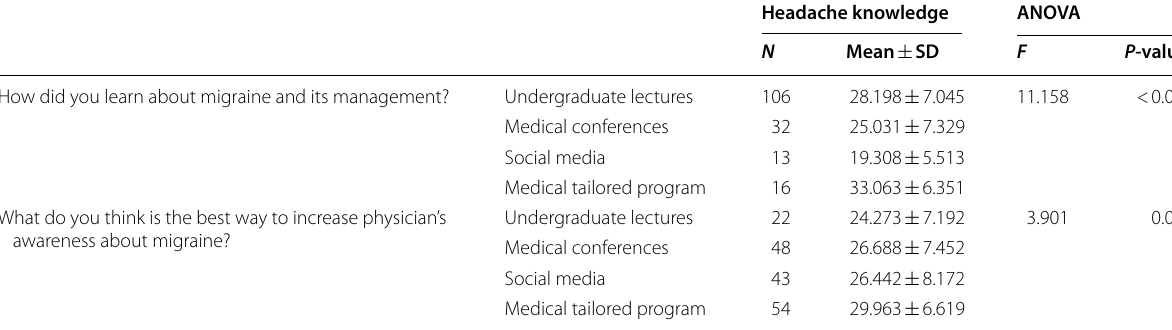
Table 3 Comparing knowledge among non-neurologists with methods of education